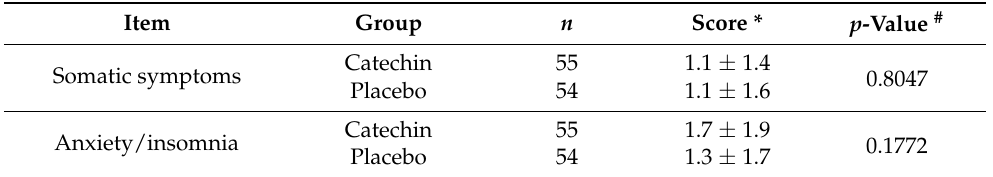
Table 3. Comparison of subscale scores for GHQ60 between the placebo ( n = 54) and catechin ( n = 55)